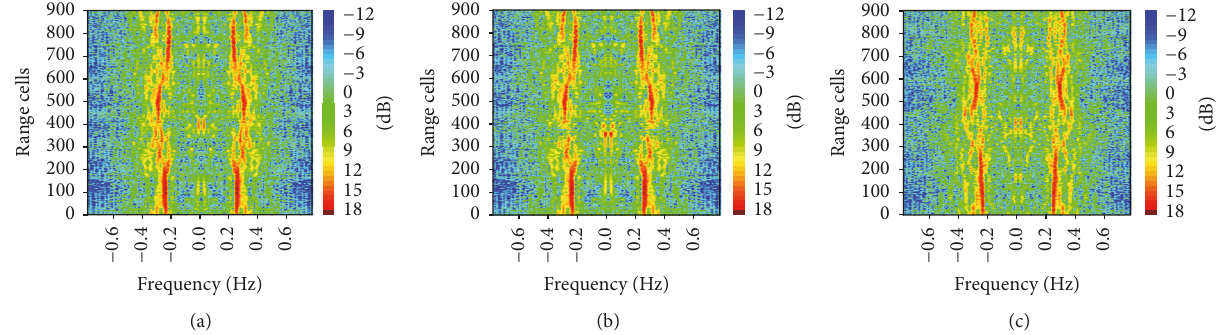
Figure 10: Power spectra of the temporal correlations of the texture for DS2: (a) sum channel. (b) Elevation difference channel. (c) Azimuth difference